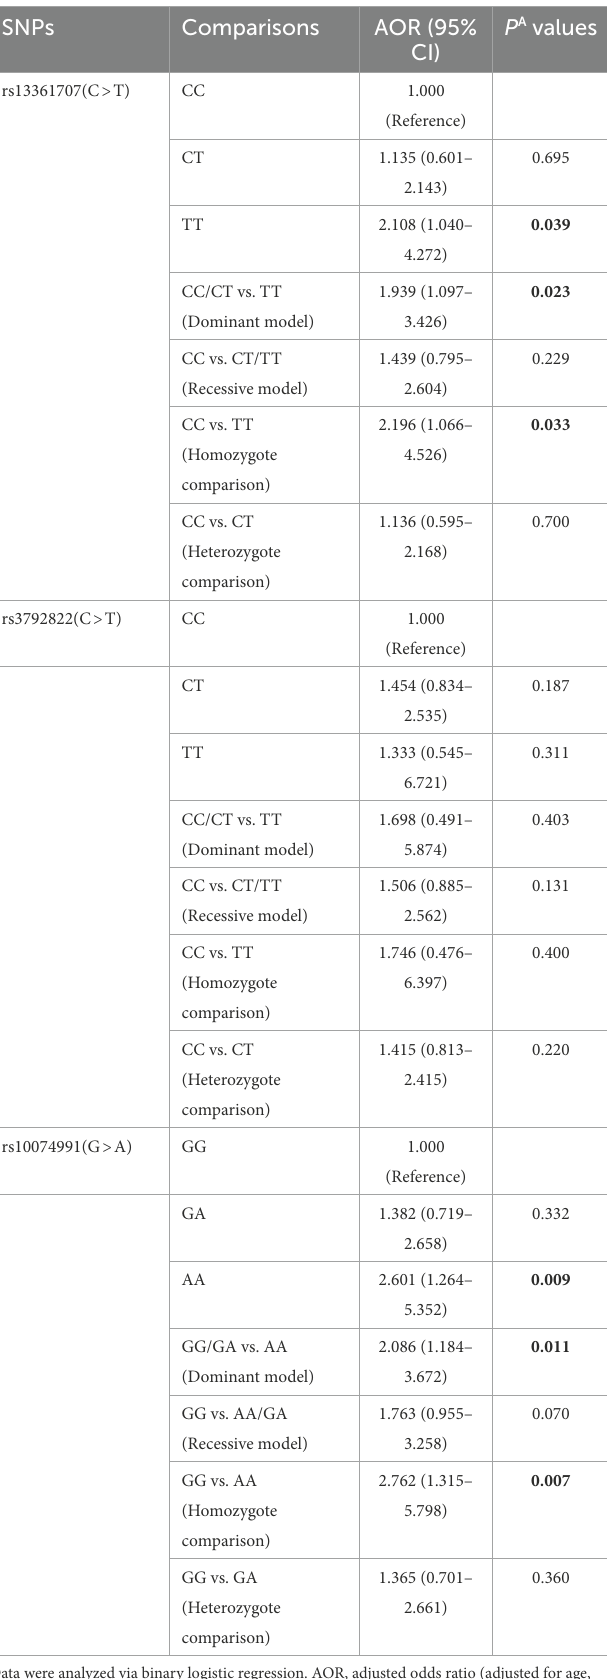
TABLE 3 The association between PRKAA1 genetic polymorphisms and the risk of PHN (adjusted for age, gender, and BMI). SNPs Comparisons